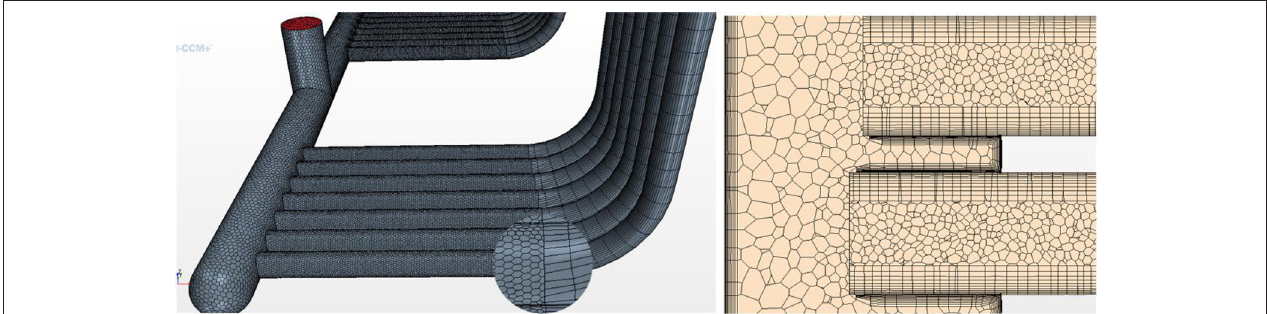
FIGURE 4 | The mesh applied in the geometry mode.